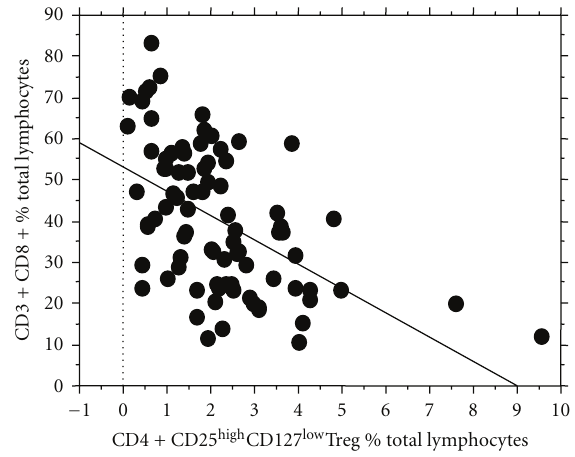
Figure 2: Inverse correlation between T-e ff ector cells and Treg. Percentages of CD3+CD8+ T-e ff ector cells and CD4+CD25highCD127low Treg are inversely correlated ( r = − 0 . 55, P < 0 . 0001) as shown by the trend line. Dots correspond to individual samples from 84 patients. CD: cluster of di ff erentiation, Treg, regulatory T cells.